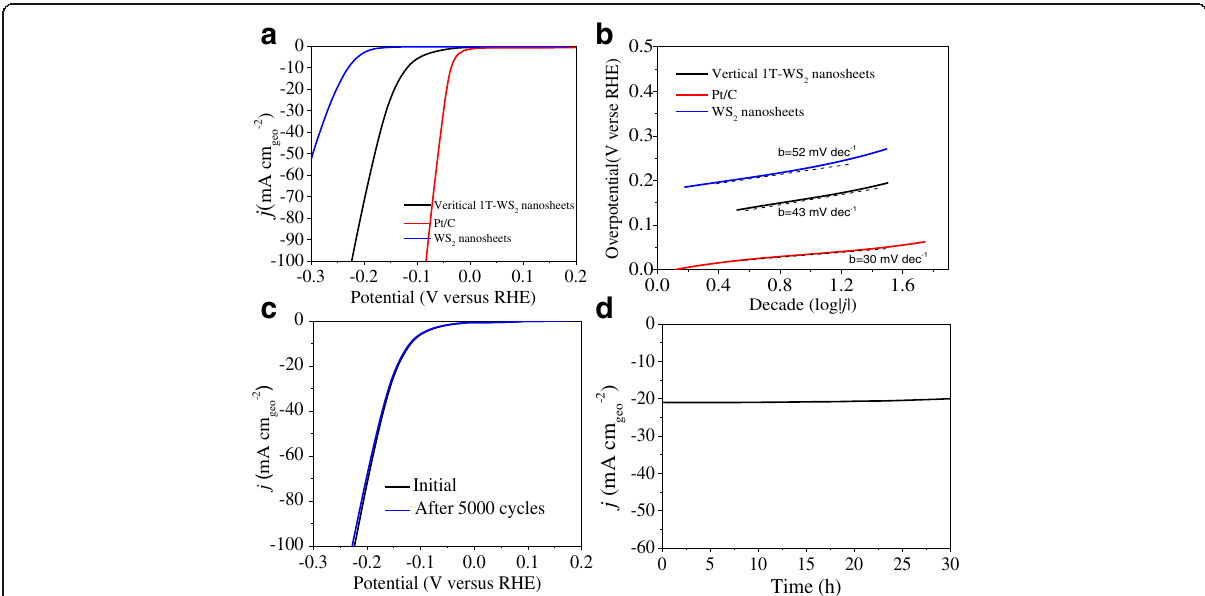
Fig. 6 a Polarization curves and b Tafel plots of Pt/C, WS 2 nanosheets, and vertical 1T-WS 2 nanosheets in 0.5 M H 2 SO 4 at a scan rate of 5 mV/s. c Durability test showing negligible current loss even after 5000 CV cycles and d time dependence of the current density curve at an overpotential of 160 mV versus RHE for vertical 1T-WS 2 nanosheets (no i R compensation)